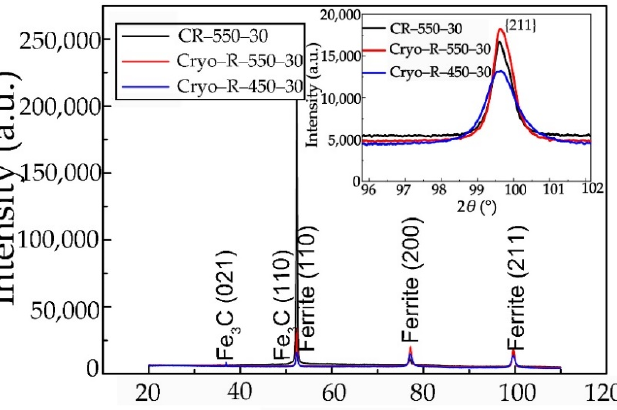
Figure 5. The widened {211} diffraction peaks showing the decreased grain size in specimens cryorolled at LNT compared with specimen